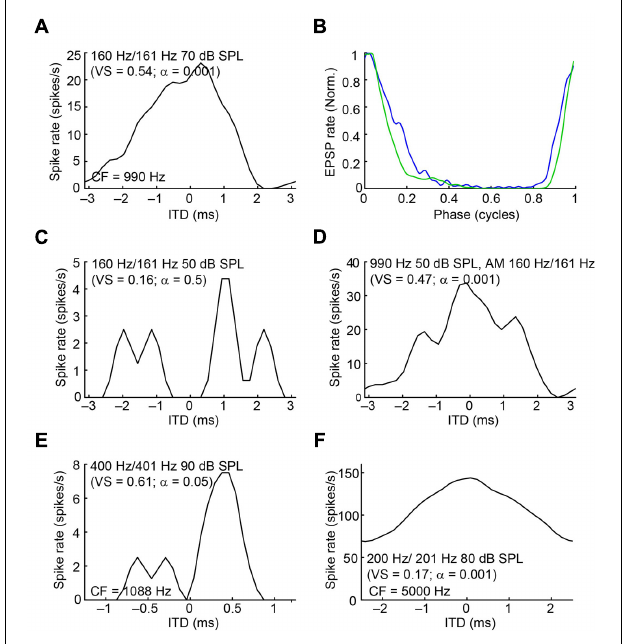
FIGURE 14 | ITD tuning of mLNTB neurons. (A) ITD function of an mLNTB neuron in response to a binaural beat stimulus (160 Hz/161 Hz, 70 dB SPL) (B) Cycle histograms of subthreshold EPSPs from the neuron in A in response to monaural tones corresponding to the binaural beat stimulus used in A (green: response to contralateral stimulus, blue: response to ipsilateral stimulus). (C) ITD function of the neuron in A to the same binaural beat stimulus as in A but at a lower SPL (50 dB SPL). (D) ITD function of the neuron in (A,C) to an amplitude-modulated tone with a binaurally beating envelope. Carrier frequency: 990 Hz. Modulation frequency: 160 Hz/161 Hz. Sound intensity: 50 dB SPL. (E,F) Similar to (A) , for 2 other mLNTB neurons. Respective stimuli: 400 Hz/401 Hz, 90 dB SPL; 200 Hz/201 Hz, 80 dB SPL; CF, vector strength (VS) and Rayleigh α of ITD tuning are indicated in (A,C–F)